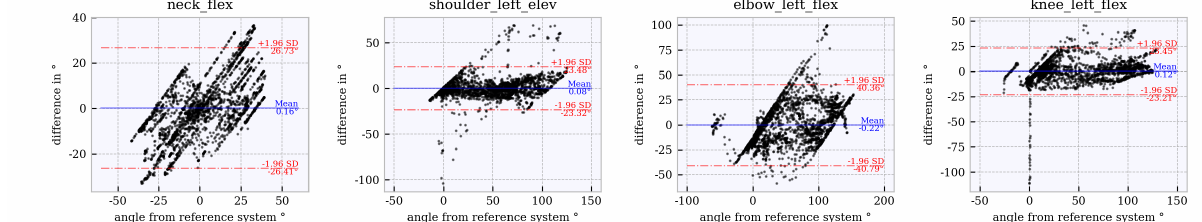
Figure 16. Bland–Altman plot for tracker configuration 9 ; x does not show the average of both systems but the joint angles of the reference system, Qualisys.